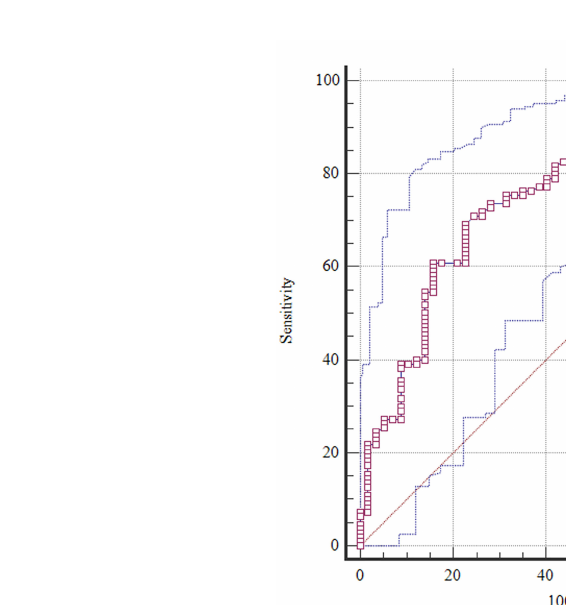
FIGURE 5 Receiver operating characteristic curve of entropy with 95% con fi dence interval based on A-ZOOMit for the differentiation between benign and malignant